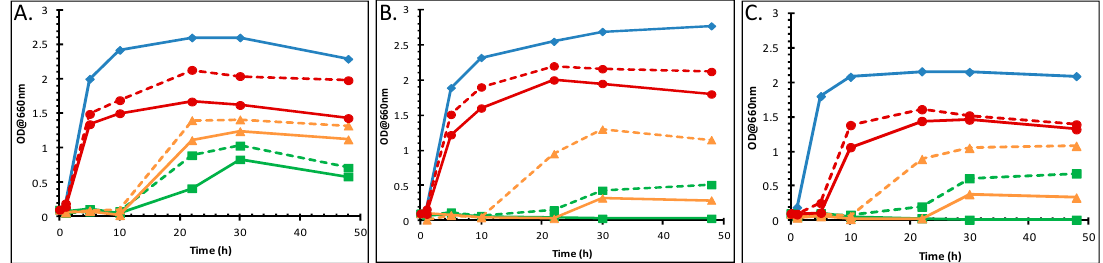
Figure 1. Influence of 7 mM MgSO 4 on growth of P. putida DOT-T1E strains in the presence of toluene. Growth curves of: ( A ) the wild-type DOT-T1E; ( B ) the mutant DOT-T1E-PS28; and ( C ) the mutant DOT-T1E-18. Symbols and colours represent different growth conditions. Control cultures with no toluene (blue closed diamonds), exposed cultures to 0.1% ( v / v ) toluene (red closed circles), 0.5% ( v / v ) toluene (yellow closed triangles), 1% ( v / v ) toluene (green closed square). Solid and dotted lines represent the absence and presence of metal ion in the culture respectively. A 1/10 dilution of 100 µL samples was prepared to determine the turbidity at 660 nm.